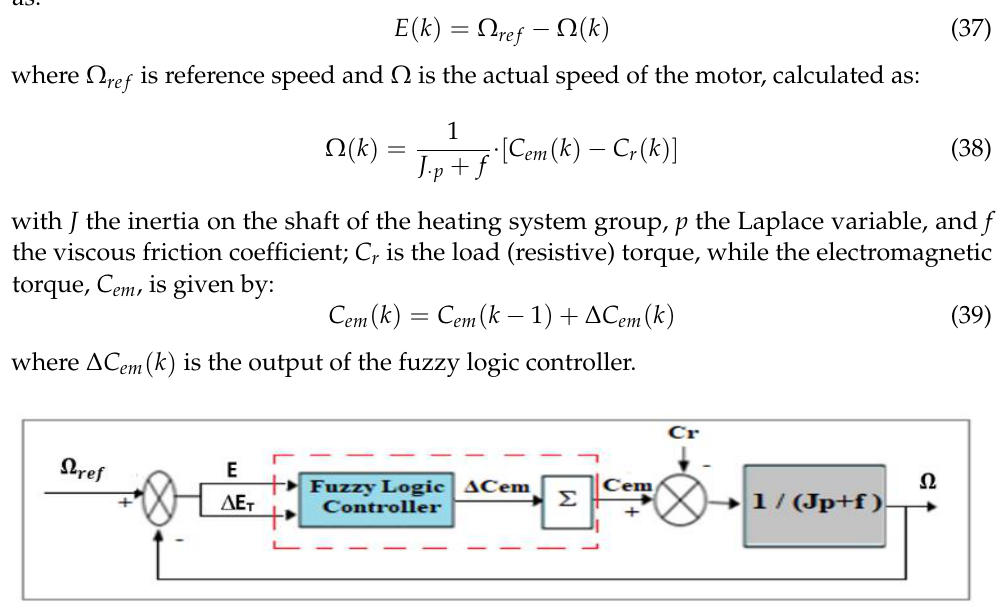
Figure 11. Basic FL controller for the yellow block in Figure 9.